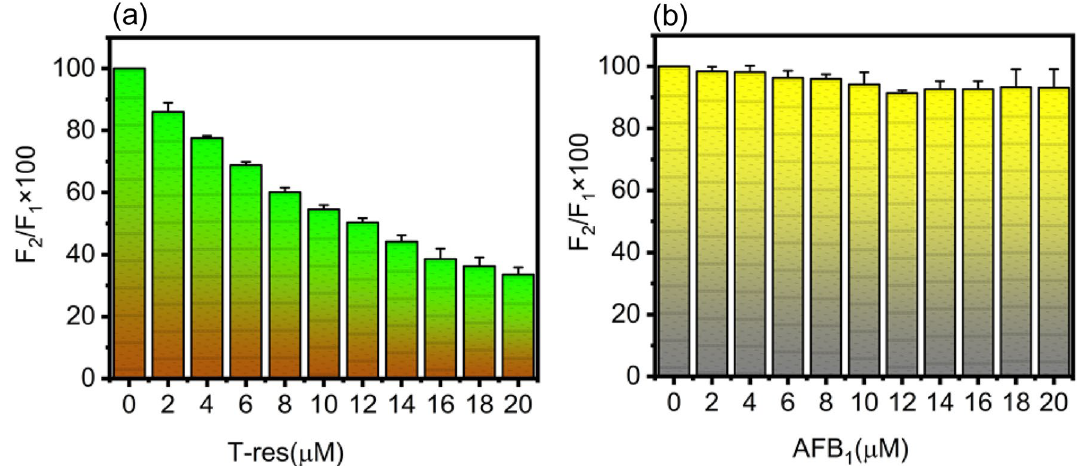
Figure 8. Graphical representation of (a) AFB 1 displacement by trans -resveratrol in HSA-AFB 1 system, (b) trans -resveratrol displacement by AFB 1 in HSA-T-res system. At the level of 0.05 (p < 0.05), the data is significant. Error bar represents the standard deviation value (mean ± SD).